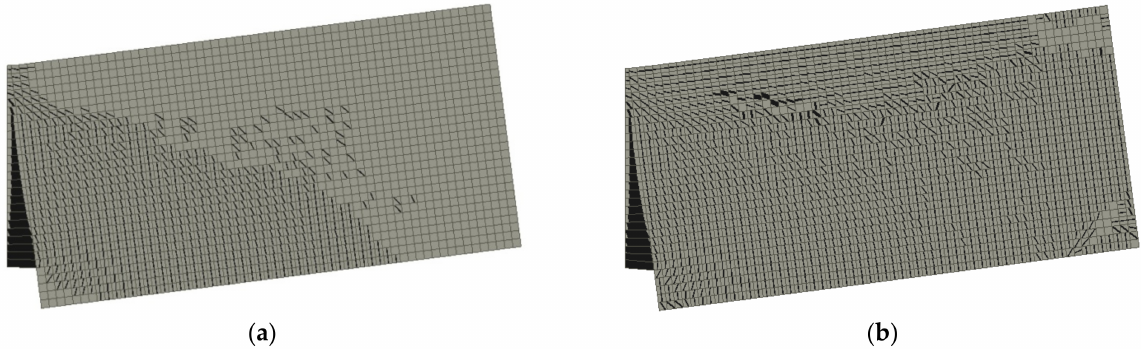
Figure 16. Crack propagation in all models for CMOD = 2.5 mm: ( a ) 0.5% and ( b ) 1.5%.